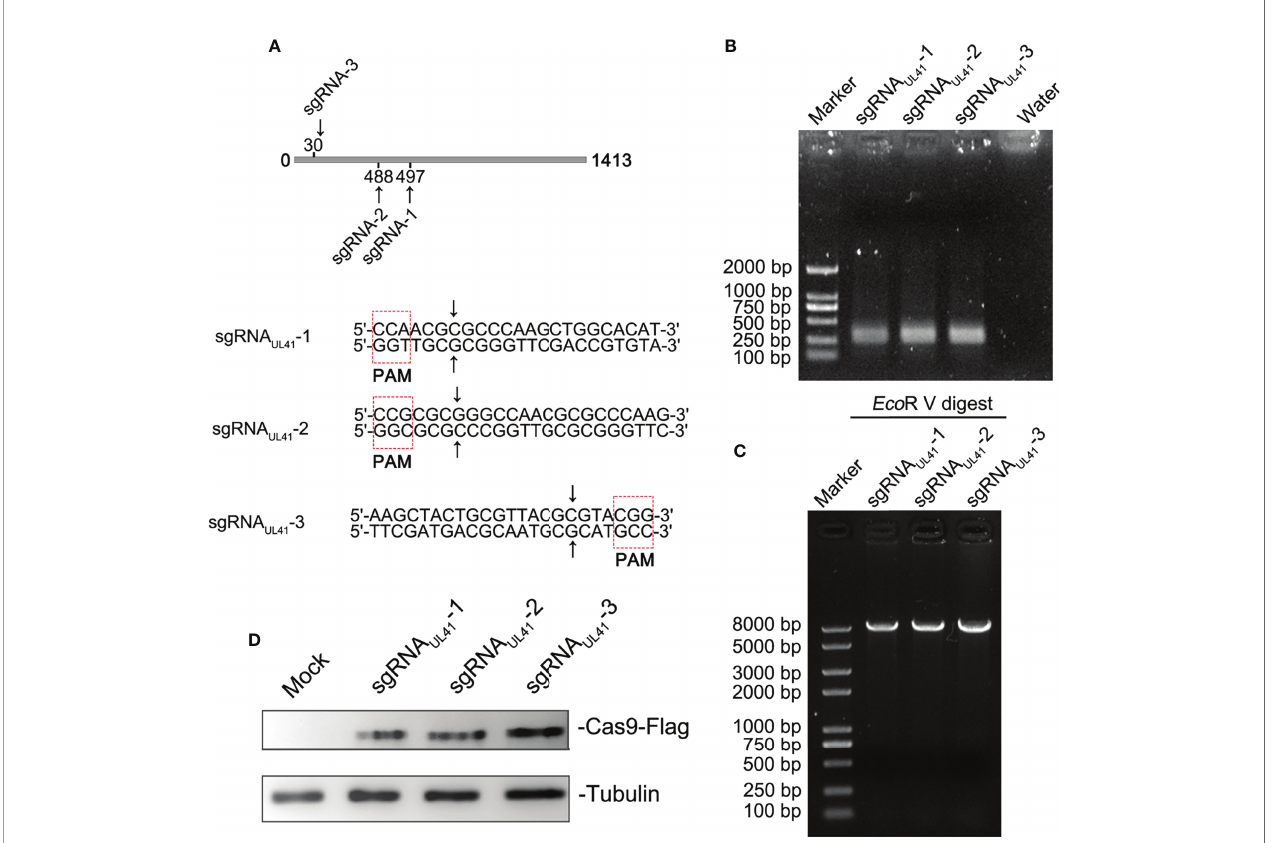
FIGURE 1 | Generation of CRISPR/Cas9 sgRNA plasmids and construction of BHV-1 UL41 − . (A) CRISPR/Cas9 sgRNA-targeted sequences and PAM array. Three sgRNA targeting positions are marked in the UL41 sequence diagram. The CRISPR/Cas9-predicted cleavage sites are indicated by arrows. The red dotted frame areas are the PAM arrays. (B) PCR ampli fi cation of recombinant plasmids sgRNA UL41 1 – 3. The lanes are marked with different recombinant plasmids. Water was used for the negative control lane, and the DNA marker was a 2-kb molecular ladder. The molecular weight of the speci fi c ampli fi ed fragment of the positive recombinant plasmids was 300 bp. (C) Restriction endonuclease digestion identi fi cation of recombinant plasmids. Digestion of the pX330 vector was performed with the Eco RV restriction enzyme, and the DNA marker was a 8-kb molecular ladder. (D) Analysis of the transfected CRISPR/Cas9 recombinant plasmids. Mock indicates BL cells treated with the transfection agent. Cas9 protein expression was detected with a mouse anti-Flag antibody. The three sgRNA recombinant plasmids are marked above the lane. Tubulin was the internal reference